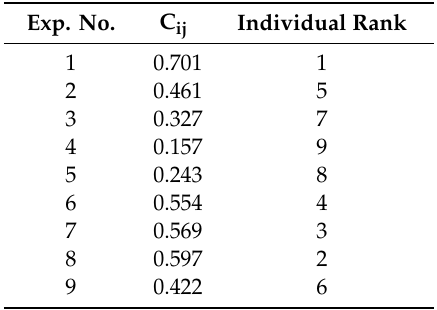
Table 8. Values of relative closeness and